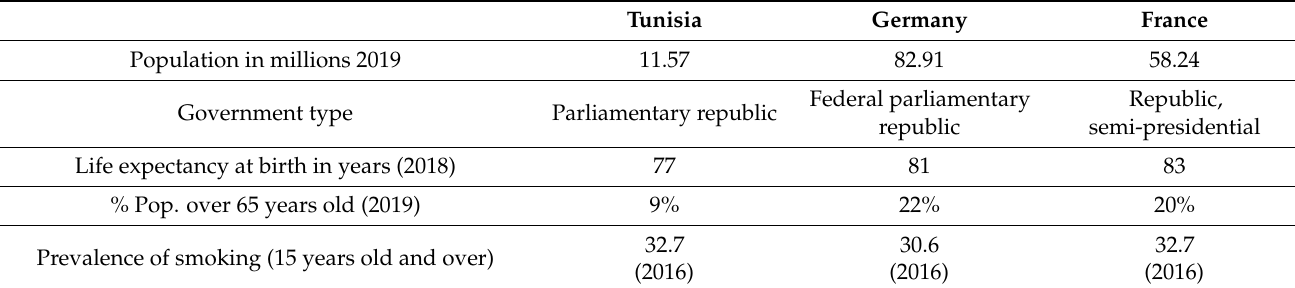
Table 1. Demographic data relevant to the impact of COVID-19 in Tunisia, Germany,